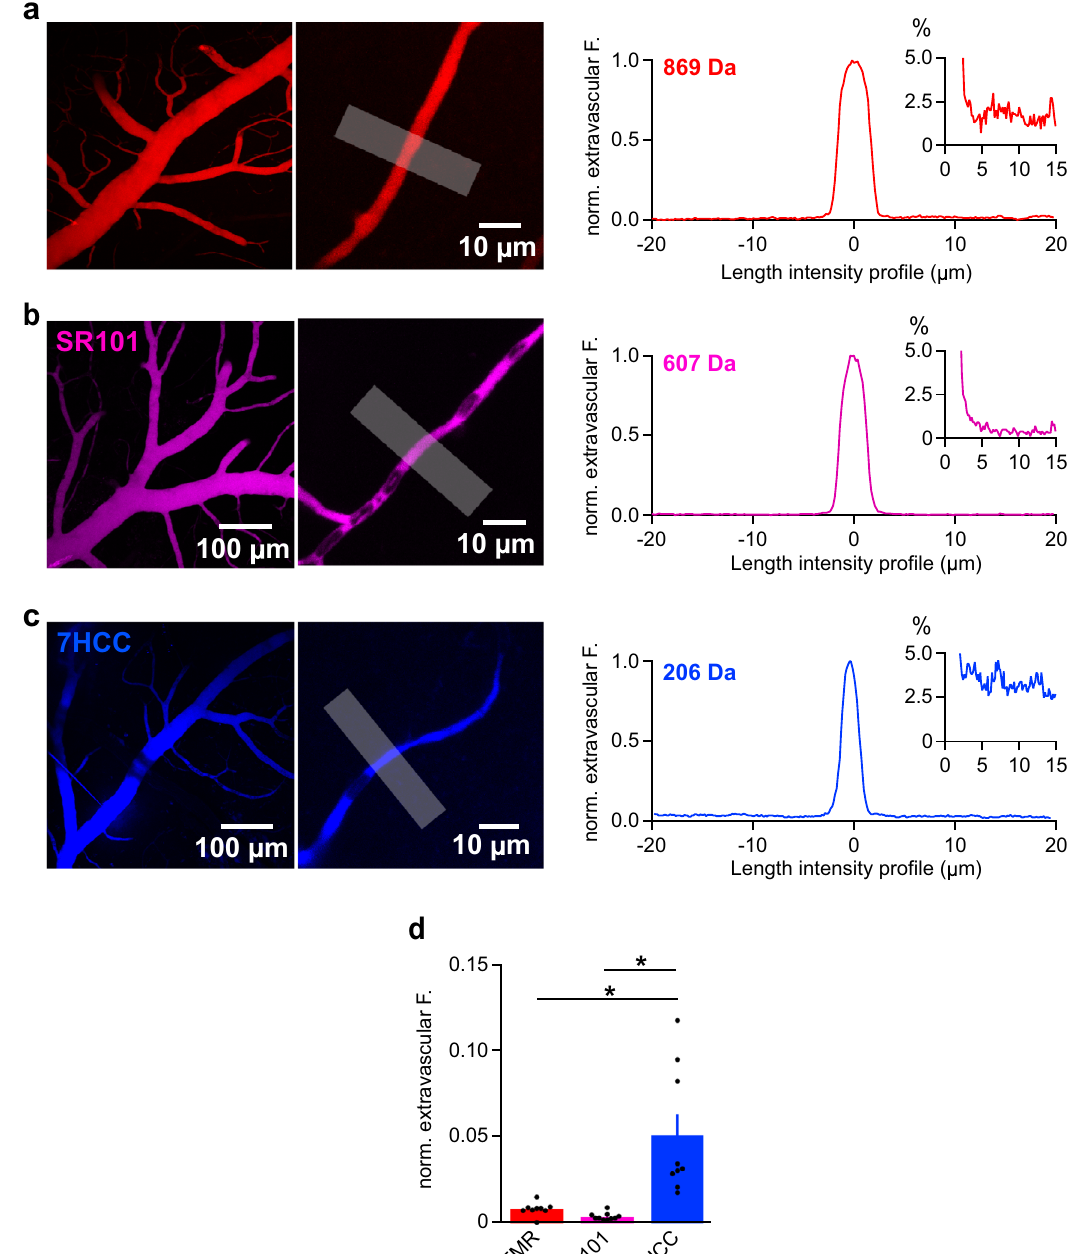
Fig. 2 | Tracers of variable molecular size show differential diffusion rates across the BBB. a MIP of TMR-injected vascular tree and a single frame of a capillary (left) and the spatial fl uorescence pro fi le of an ROI (white line) across a capillary at 30min (left) with less than 2% extravascular fl uorescence (see inset). Images represent 9 experiments. b MIP at t 30 of SR101 injection (left) and the line pro fi le of an ROI across a capillary (right) showing an extravascular fl uorescence below 1% (see inset). Images are representative of 5 experiments. c MIP of the vasculartreeandasingleframeofacapillaryrecordedatt 30 of7HCCinjection(left) and the spatial fl uorescence pro fi le of an ROI (white line) across the capillary at